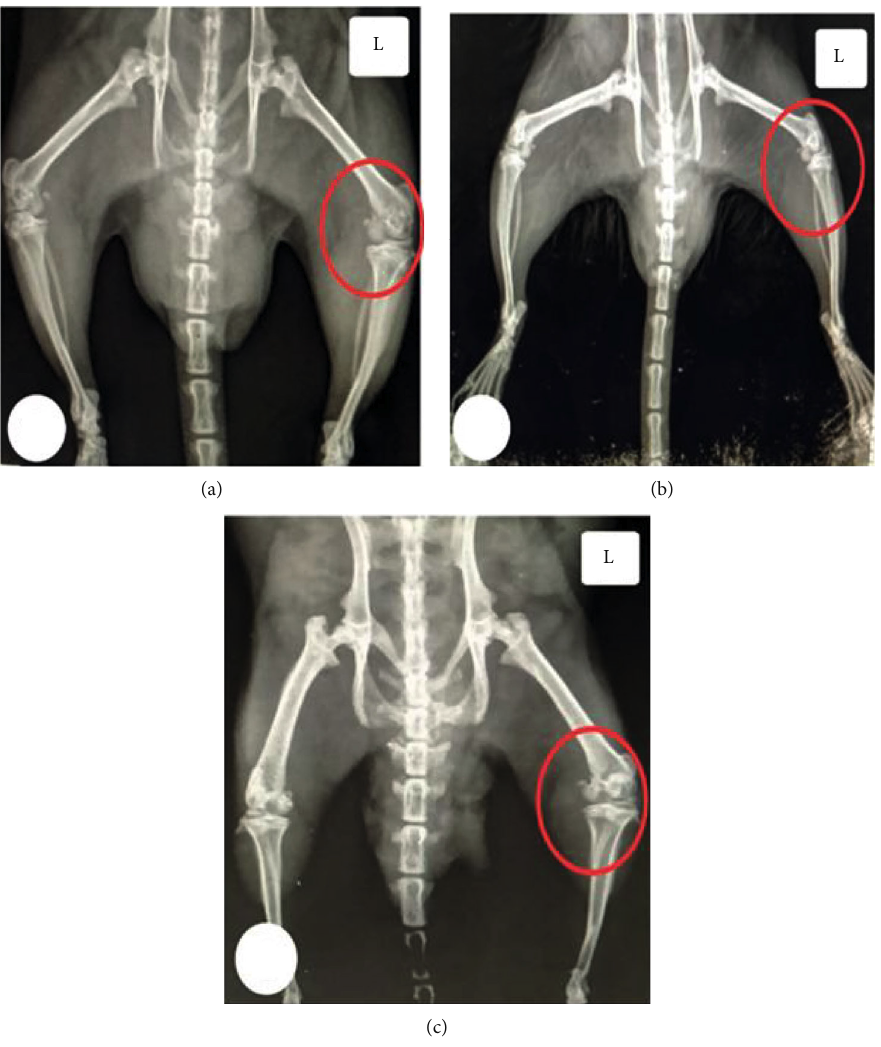
Figure 6: X-ray image showing the left knee joints (L) of all groups: (a) the normal knee joints; (b) MIA-treated knee joints depicting radiographic alternations such as erosion of the cartilage surface, osteophytes, and joint space narrowing; and (c) MIA+CUR-loaded PLGA NP-treated group, with joints nearly similar to those of the normal control. Table 2: E ff ect of CUR-loaded PLGA NPs on the serum levels of TNF- α , IL-1 β , IL-6, TGF- β , and IL-10 in MIA-induced OA in rats. Groups Normal